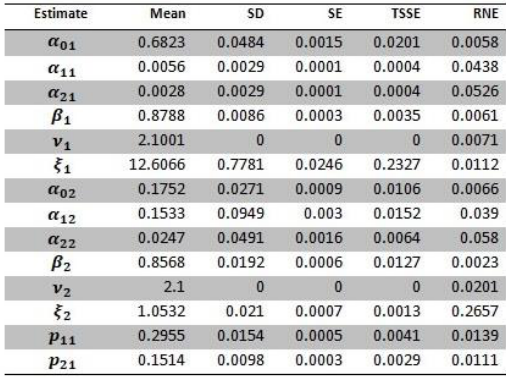
Table 8: Estimates of 2-State Regime